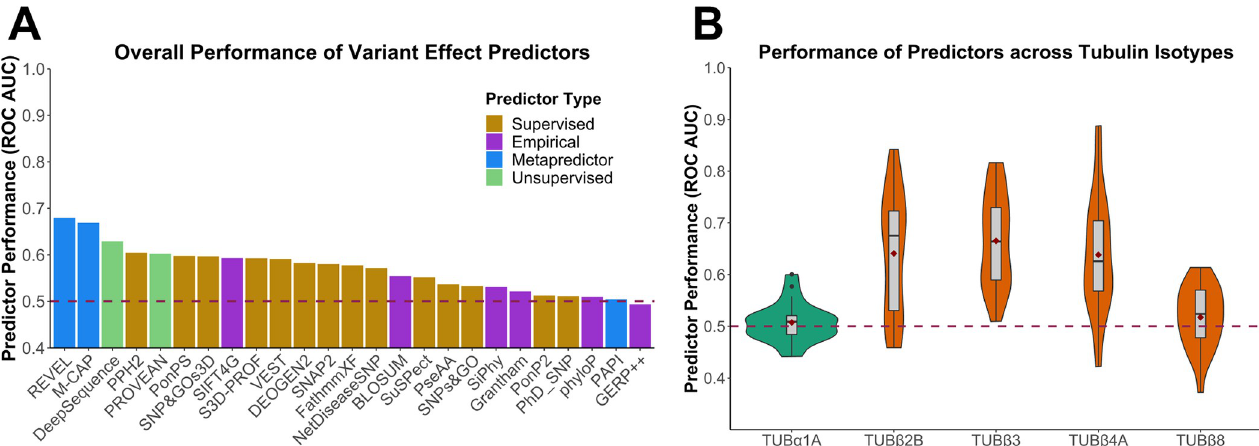
Fig 4. Assessment of VEP performance for identification of pathogenic tubulin mutations. (A) ROC AUC values for each VEP across all tubulin- α and - β isotypes with at least one identified pathogenic mutation, colour coded according to predictor category. (B) Distribution of ROC AUC values across all VEPs for isotypes with at least 10 identified pathogenic missense mutations. Dashed line indicates the performance of a random predictor. Maroon diamonds indicate the mean area.